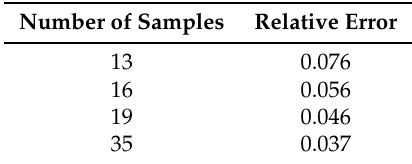
Table 1. Relative error in the effective conductivity prediction depending on the number of samples considered in the regression (training